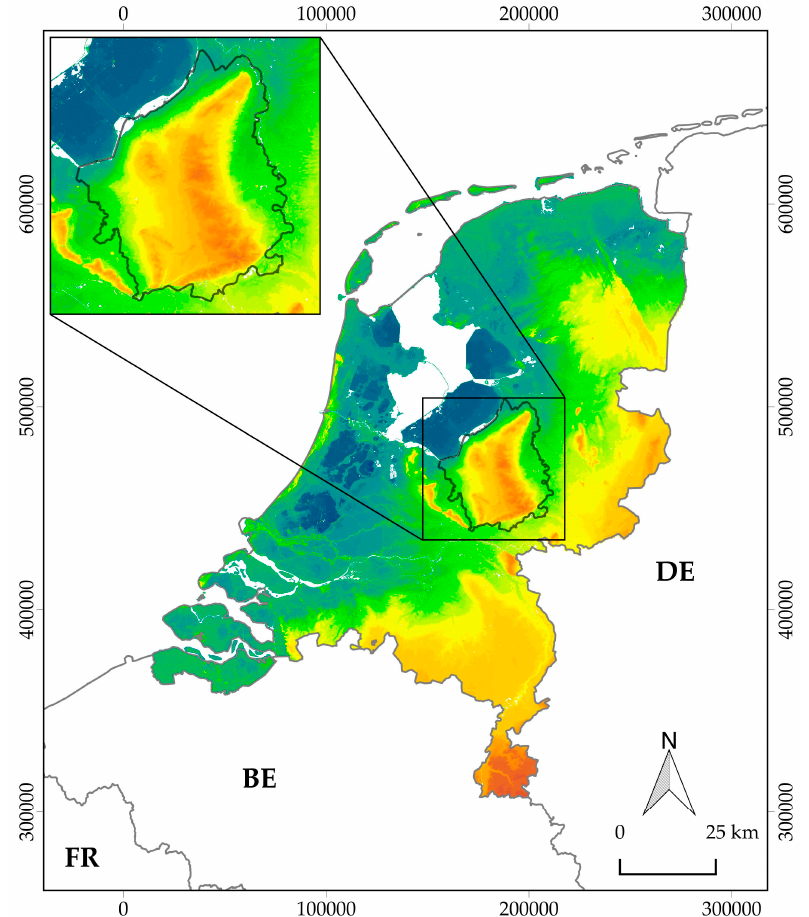
Figure 2. The research area on a height model of The Netherlands (source of the background image and height model: Reference [63]; coordinates in Amersfoort / RD New, EPSG: 28992).